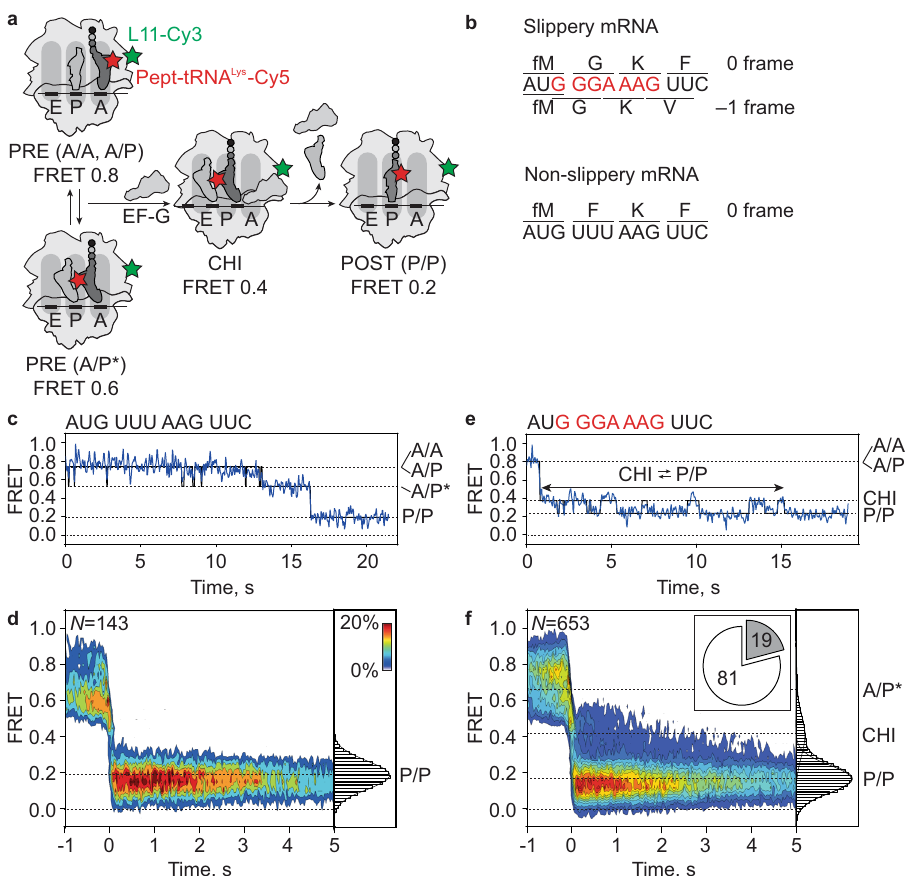
Fig. 1 EF-G-induced translocation of pept-tRNA. a Schematic of the smFRET experiment. Pept-tRNA Lys -Cy5 (red star) fl uctuates between A/A, A/P, and A/P* states in the absence of EF-G. Upon EF-G addition, pept-tRNA moves into a transient CHI state before reaching the P/P state. The movement is monitored by change in FRET between pept-tRNA Lys -Cy5 and L11-Cy3 (green star). FRET values are assigned to PRE and POST states in independent experiments (Supplementary Fig. 1) and validated by distance measurements based on cryo-EM structures 19,24,25 . b Coding sequences of mRNA constructs. Slippery sequence encodes fMet-Gly-Lys-Phe peptide in 0 frame and fMet-Gly-Lys-Val in − 1 frame. Non-slippery mRNA that does not support frameshifting encodes only the 0-frame peptide fMet-Phe-Lys-Phe. c Representative smFRET time trace showing tRNA translocation on non-slippery mRNA. Trace shows fl uctuations between FRET 0.8 (A/A, A/P) and 0.6 (A/P*) followed by rapid transition to FRET 0.2 (P/P). Black line shows the HMM fi t of the data here and in all smFRET traces. d Contour plot showing distribution of FRET values during tRNA translocation on non-slippery mRNA. Transitions occur from either A/A and A/P or A/P* to P/P in less than 33 ms. Traces are synchronized to the fi rst transition below FRET 0.5. Histogram at the right shows distribution of FRET values after synchronization. Data are from 5 independent experiments ( N = 5). e Representative smFRET time trace showing tRNA translocation on slippery mRNA. Trace shows rapid transition from FRET 0.8 (A/A, A/P) to FRET 0.4 (CHI) 23,46 , followed by fl uctuations between FRET 0.4 and 0.2 before adopting a long-lived FRET 0.2 state (P/P). f Contour plot showing distribution of FRET values during translocation on slippery mRNA. The contour plot contains mixture of trajectories. 81% of traces show direct transitions from A/A, A/P or A/P* to P/P. 19% of traces show transitions from A/A, A/P, or A/P* to CHI followed by fl uctuations between CHI and P/P states before transition to long-lived P/P state. Traces are synchronized to the fi rst transition below FRET 0.5. Histogram at the right shows distribution of FRET values after synchronization. Data are from 12 independent experiments ( N =